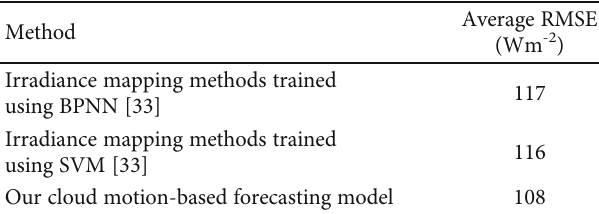
Average RMSE (Wm -2 ) 117